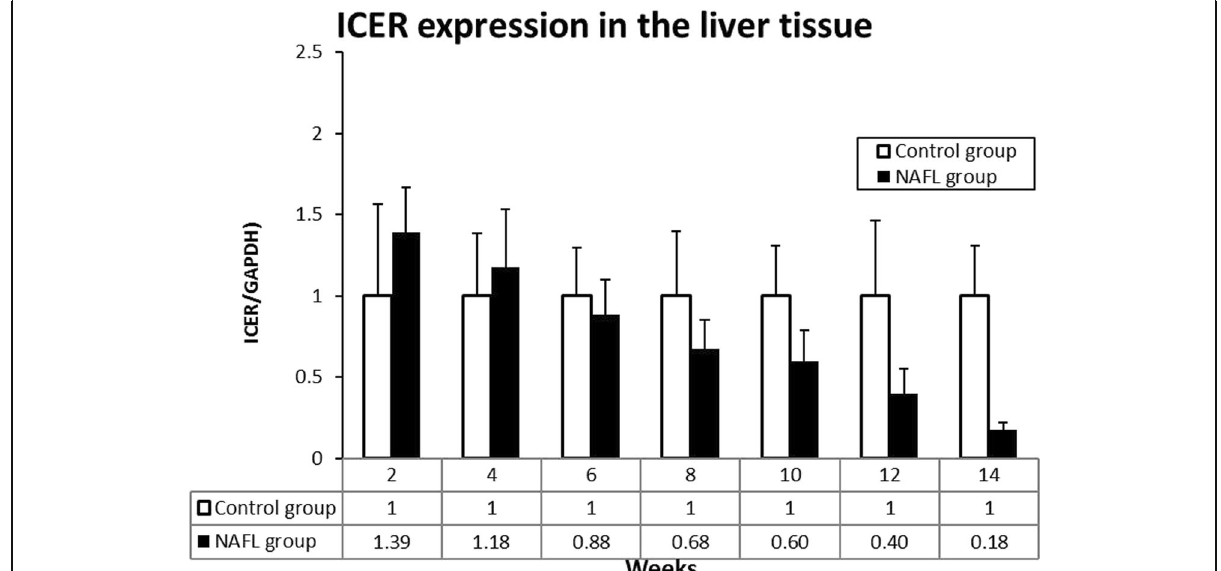
Fig. 1 The fold change of ICER gene expression in the liver tissue of control and NAFLD rats during 14weeks duration. Data are expressed as mean ± SE